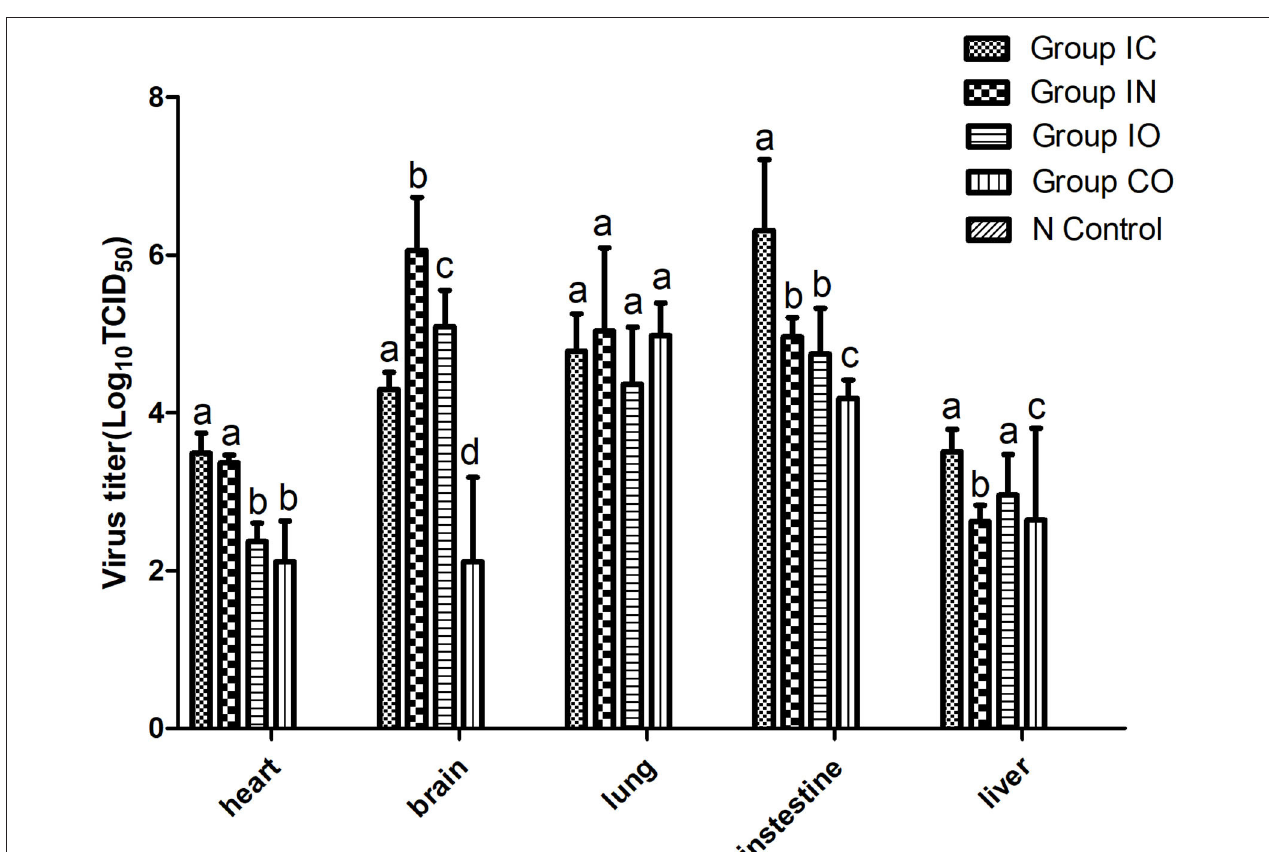
FIGURE 4 | Viral loads in different organs of pigeons post-infection. Virus titer of different tissues from dead pigeons [log 10 median tissue culture infectious dose/ml (TCID50)] were quantified by serial end-point dilution in 96-well plates using DF-1 cells. The titer was calculated by one-way analysis of variance with standard error bars. Different lowercase letters over the bars denote statistically significant differences ( P < 0.05) among different tissues after infection calculated by t -test. Non-significance ( P > 0.05) was marked up by the same lowercase letters on different bars. Different lowercase letters marked up on the bars have no relationship among these five organs and represent one